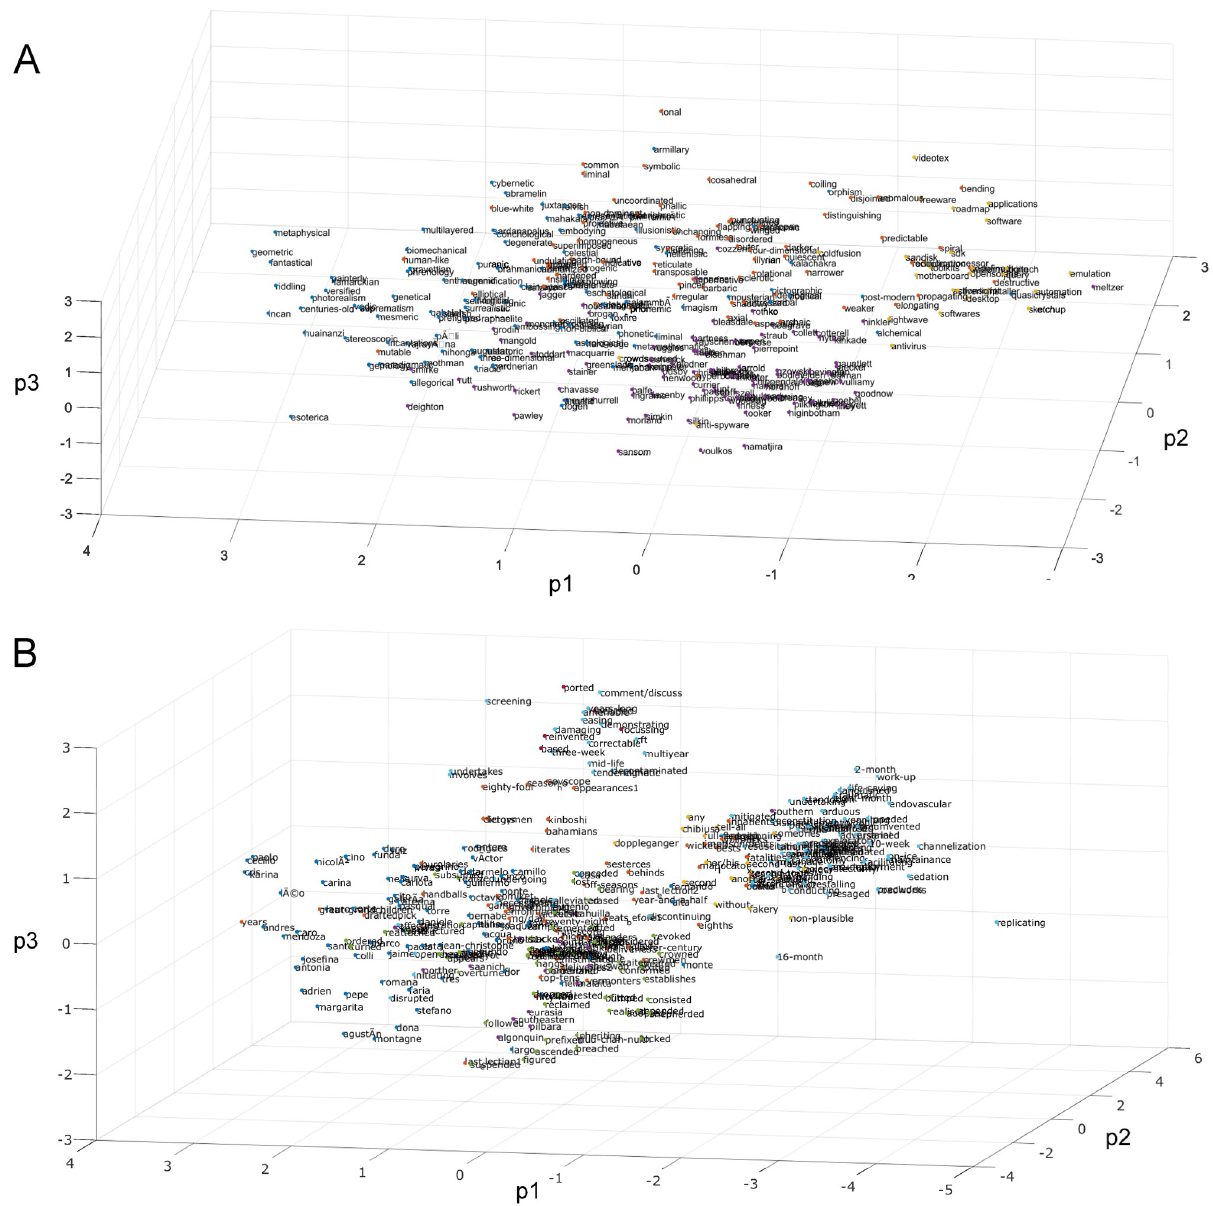
Fig 4. Example Wikipedia embedded text data. (A) Example of 4 clusters of Wikipedia words grouped by semantic similarity using word2vec embedding, plotting every second word for clarity of visualization. Principal component analysis (PCA) was used for data visualization (first three principal components were plotted), but was not used in linkage analysis. (B) Example of a 7-cluster set with every fifth word